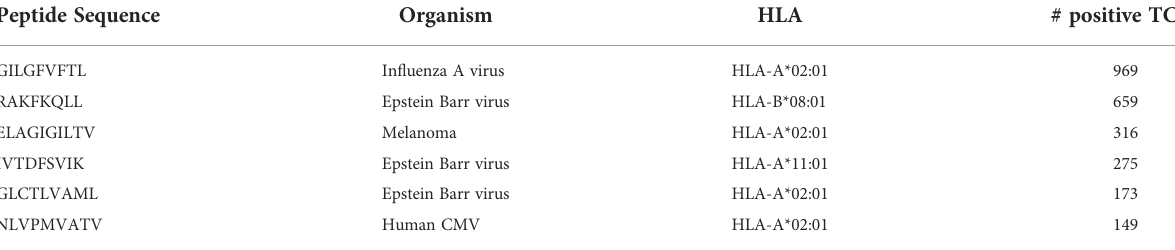
TABLE 1 Description of the peptides included in the training